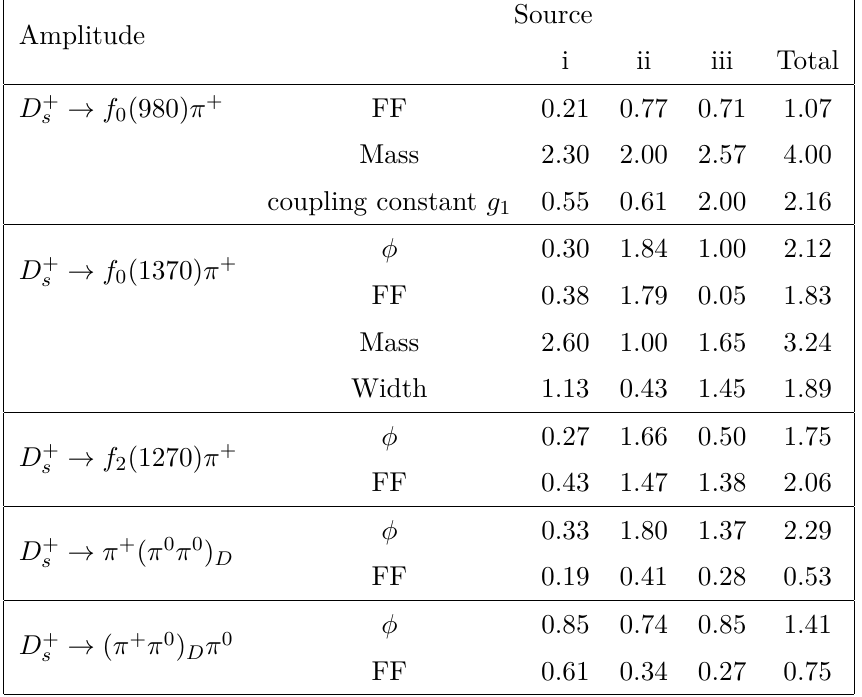
Table 6 . Systematic uncertainties on the floated masses and widths, the phase φ and FF for each amplitude in unit of the corresponding statistical uncertainty. The sources are: (i) the R values, (ii) background, (iii) Insignificancant